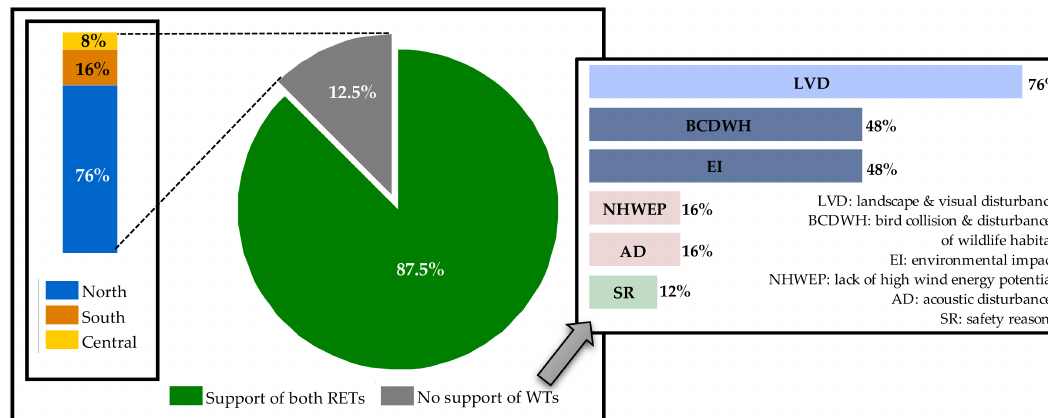
Figure 7. Local Public (LP) views (%) on Renewable Energy Technologies (RETs) per geographic segment and causes of negative reactions towards WTs’ deployment in